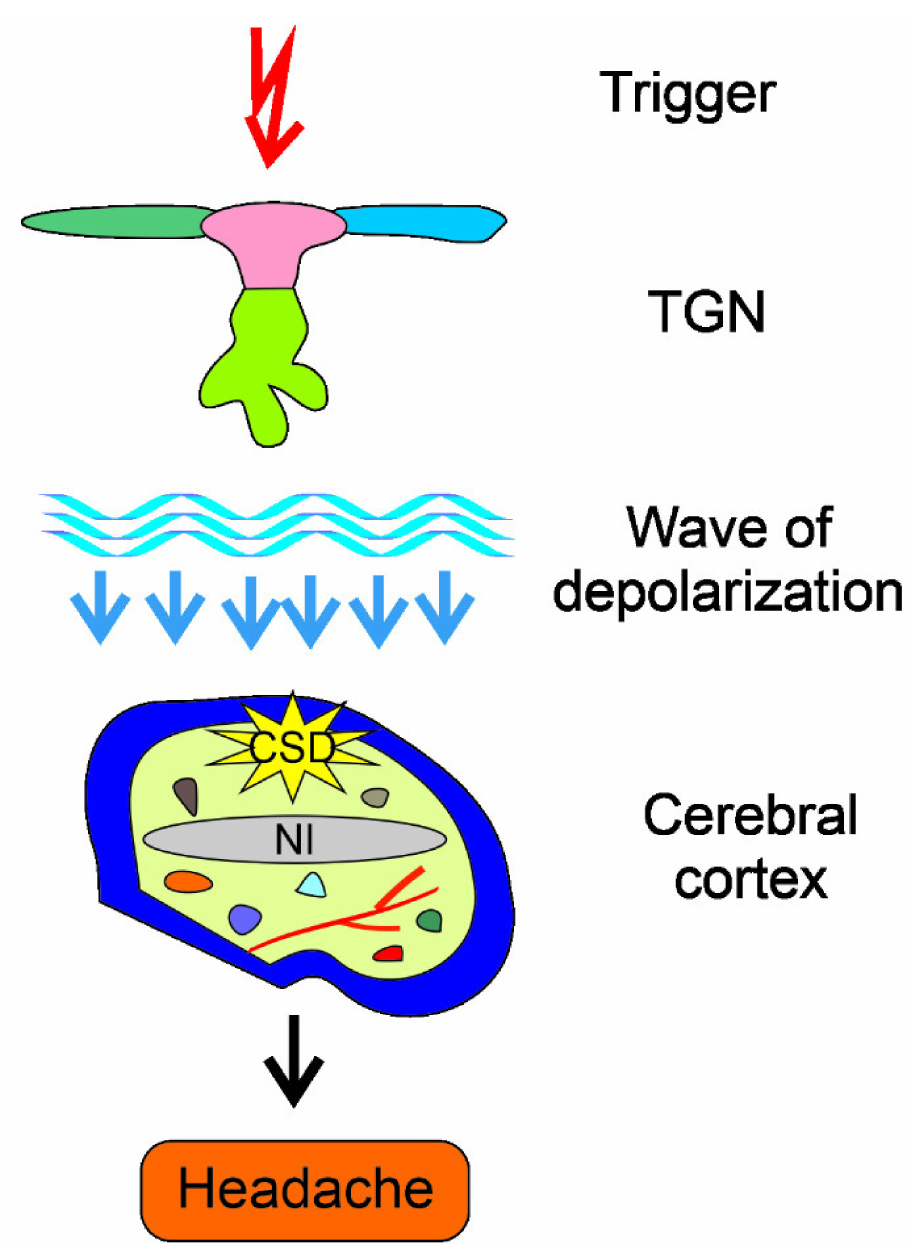
Figure 4. Mechanism of migraine headache induction by a trigger. A migraine trigger (red thunder), which may be of endogenous or exogenous origin, affects the principle sensory nucleus (pink) of the trigeminal nerve with trigeminal ganglion with fragments of the three terminal divisions of the trigeminal nerve (TGN, light green), spinal nucleus (dark green), and mesencephalis nucleus (blue). The trigger-activated trigeminal system sends a wave of depolarization, reaching the cerebral cortex and evoking cortical spreading depression (CSD) and resulting in neurogenic inflammation (NI, symbolized by extended gray oval) and release of inflammatory neurotransmitters (small color objects), which induce dilation of vessels (symbolized by red branched structure), causing the release of pain-producing prostaglandins that induce a migraine